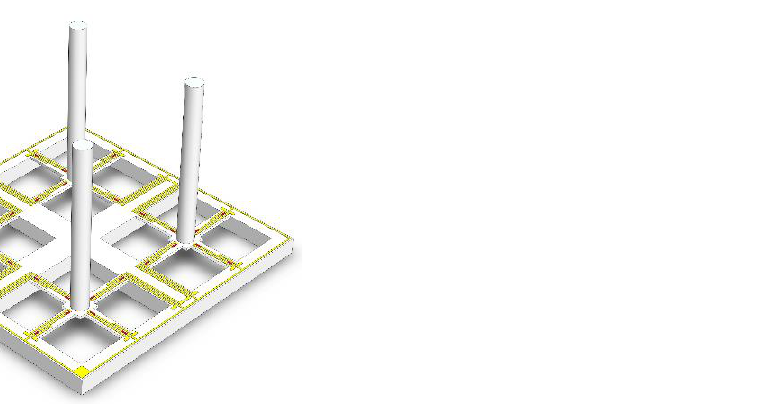
Figure 3. The FUVH structure. The piezoresistors are located at the root of the cross-beam and wired as a Wheatstone bridge.